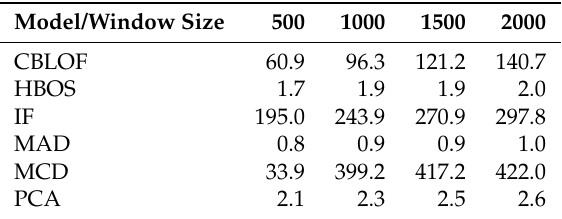
Figure 14. Plot of the computational time employed by each unsupervised method, for different window sizes. Two groups can be distinguished: CBLOF, IF, and MCD are very slow, whereas HBOS, PCA, and MAD are very fast methods. Table 1. Execution Time [ms]. The algorithm has been designed to work on a Zynq-7000 ARM cortex A9, but the execution time of the algorithms was measured on a 2.7 GHz Intel Core 5 Processor and refers to the PyOD implementation available in